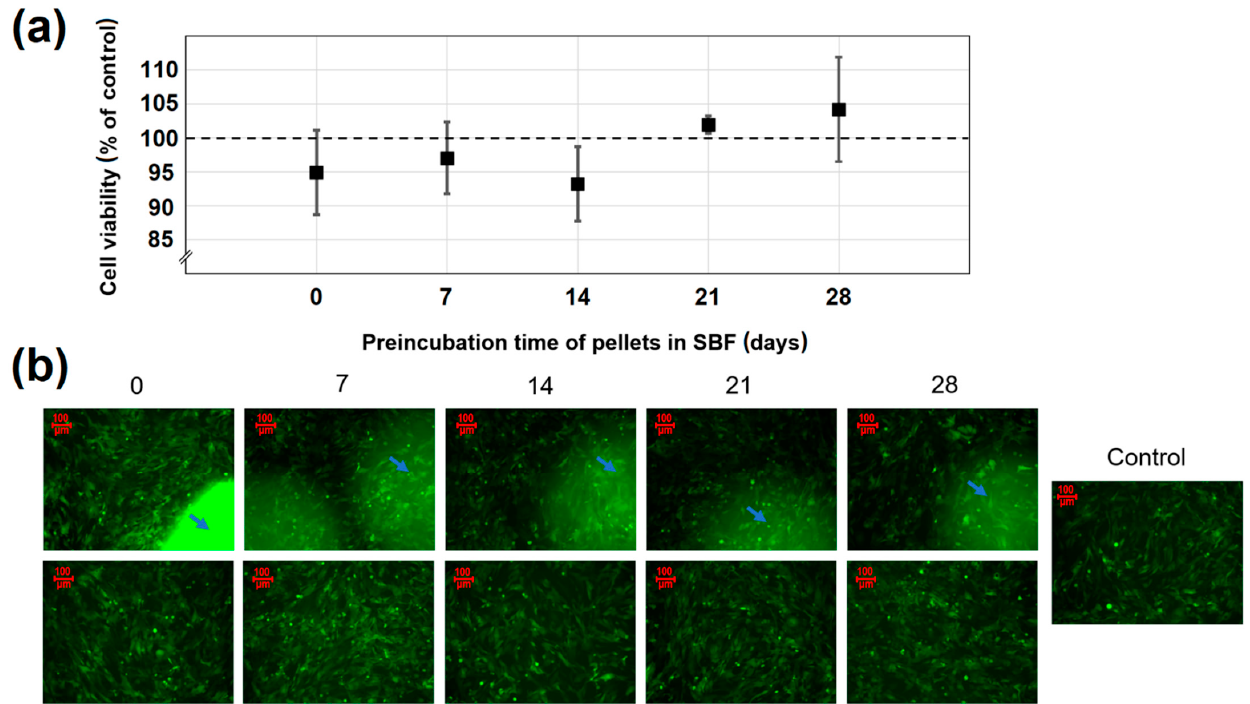
Figure 9. ( a ) The effect of both parent and preincubated in SBF pellets on osteoblast viability; ( b ) The images of the cells before (upper row) and after (lower row) pellets removal. Arrows refer to the areas of osteoblasts directly covered by pellets. Data are represented as mean ± SD ( n = 3).